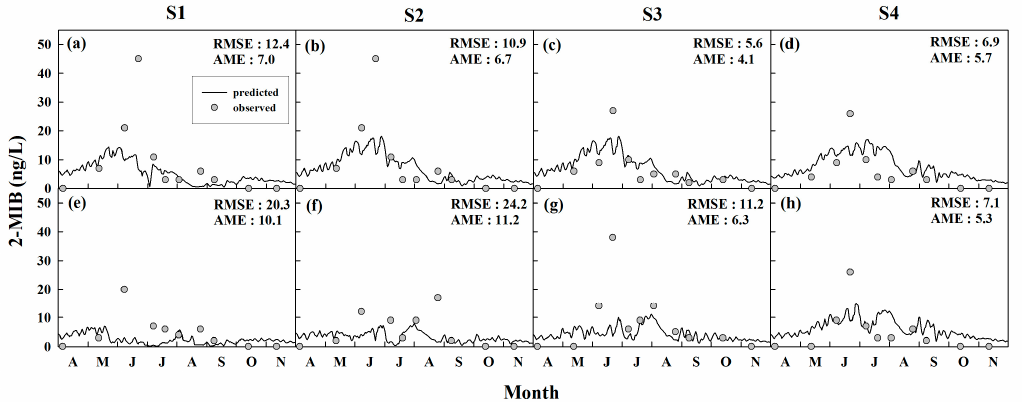
Figure 6. Predicted and observed 2-MIB concentrations at S1–S4: ( a )–( d ) upper; ( e )–( h ) middle.